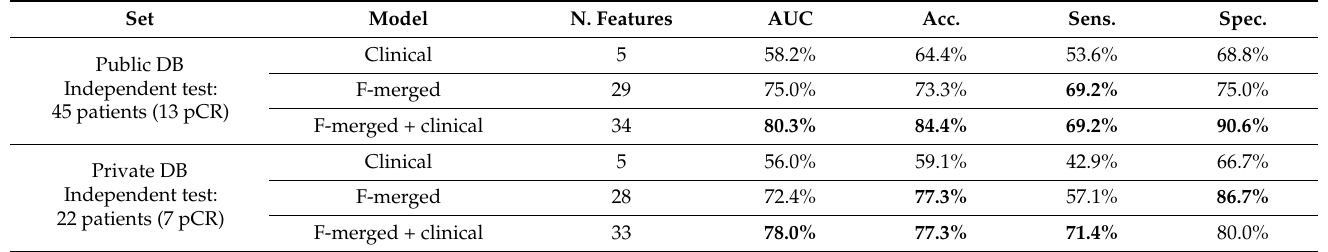
Table 3. Summary of the performances achieved by the pCR prediction models in terms of